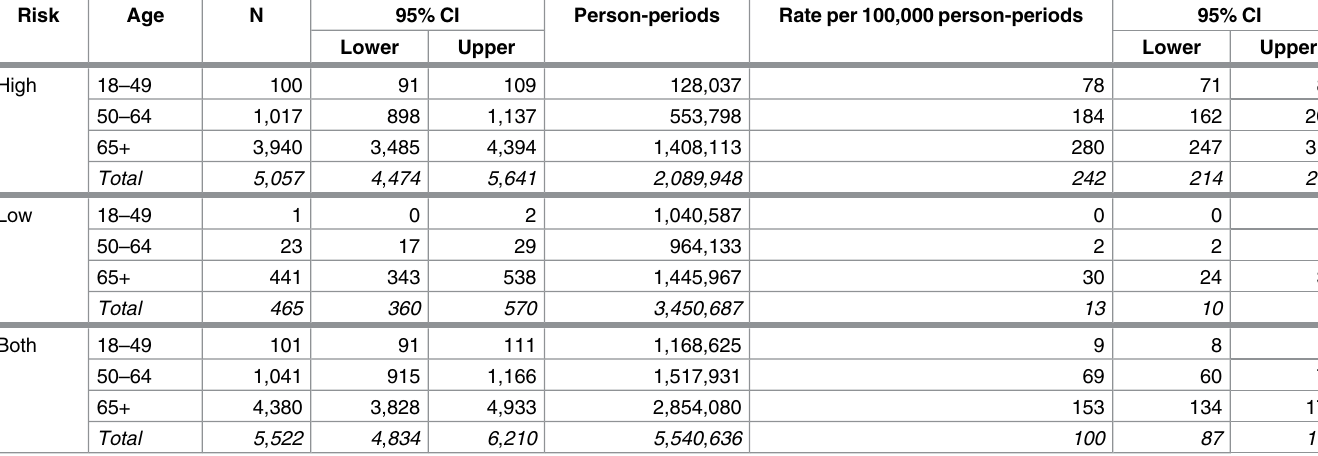
Cost per influenza-attributed encounter Annual mean estimates of direct medical costs for influenza-attributed ED visits averaged over the five year study period were similar across both risk and age groups, ranging from $592 in the high-risk 65 and older age group to $568 in the low-risk 50 to 64 age group (Table 6). For hospitalizations without extended care, the mean direct medical costs increased across age groups for both the high- and low-risk groups. In the high-risk group, the means were $13,673, $14,623 and $14,839 for those aged 18 to 49, 50 to 64 and 65 and older, respectively. In the low-risk group, the respective means were $10,872, $13,705 and $14,723. The mean direct medical costs varied across both risk and age groups for hospitalizations with extended Table 3. Annual estimates of influenza-attributed all-cause mortality by risk and age group averagedover five respiratory seasons. Risk Age N 95% CI Person-periods Rate per 100,000 person-periods 95% CI Lower Upper Lower Upper